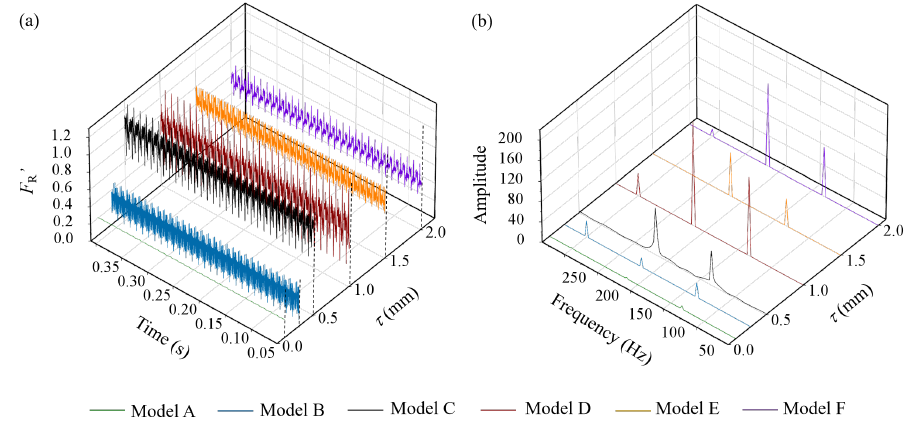
Figure 14. Normalized radial force for all six models in: ( a ) time domain; ( b ) frequency domain.